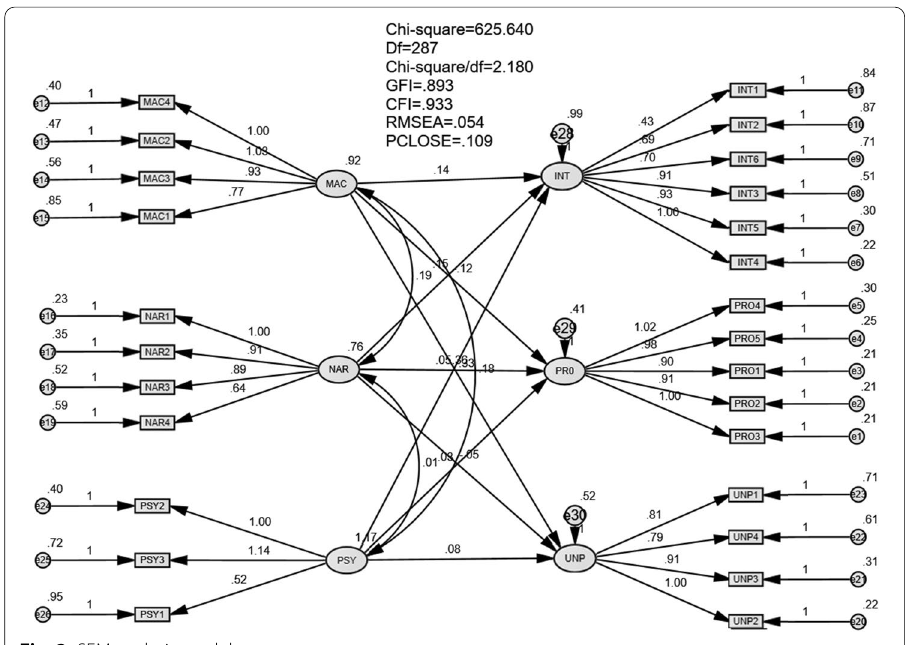
Fig. 2 SEM analysis model